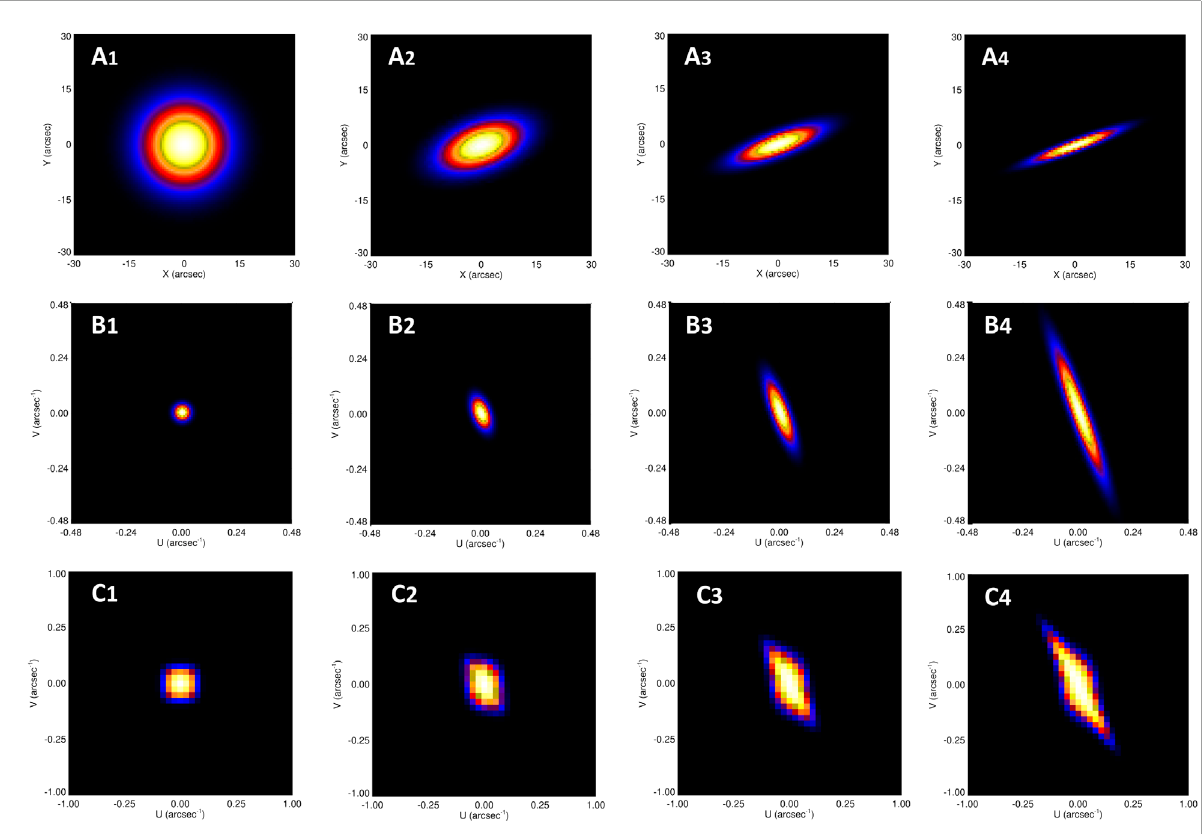
FIGURE 3 (A 1– –A 4 ) A series of idealized elliptical Gaussian sources with different eccentricities, starting with a zero-eccentricity (circular) Gaussian. (B in accordance with panel (B) of Figure 4 . Note that the FFT-generated transforms in panels (B 1 –B 4 ) are generated at spatial frequency points that have equal spacing in both u and v , whereas panels (C 1 –C 4 ) use a grid with equal spacing in √| u | and √| v | ; the differences in the shapes in the spatial frequency maps in the middle and bottom rows are primarily due to this difference in gridding, rather than to the values of the visibility amplitudes generated.